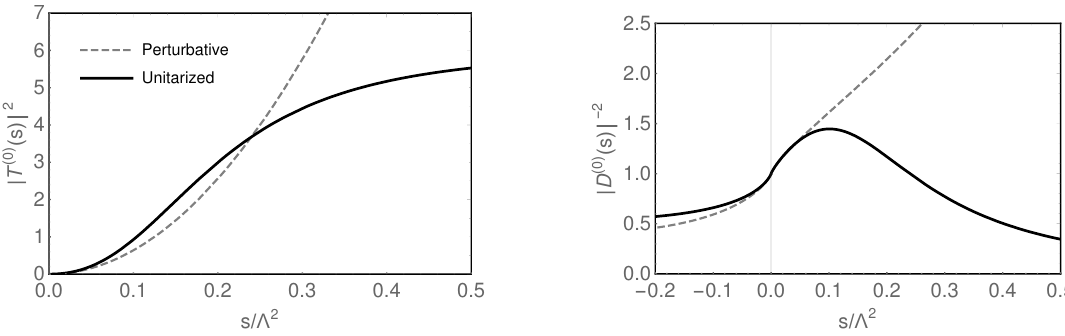
Figure 2 . The moduli squared of T (0) ( s ) (left) and 1 /D (0) ( s ) (right panel) are plotted for J = 0 as a function of s in units of Λ 2 . The presence of the resonance pole is clearly appreciated in | 1 /D (0) ( s ) | 2 for values of s much lower than | s P | . The resonance shape is strongly distorted for | T (0) ( s ) | 2 because of the zero at s = 0 . The solid(dashed) lines correspond to the full(perturbative)